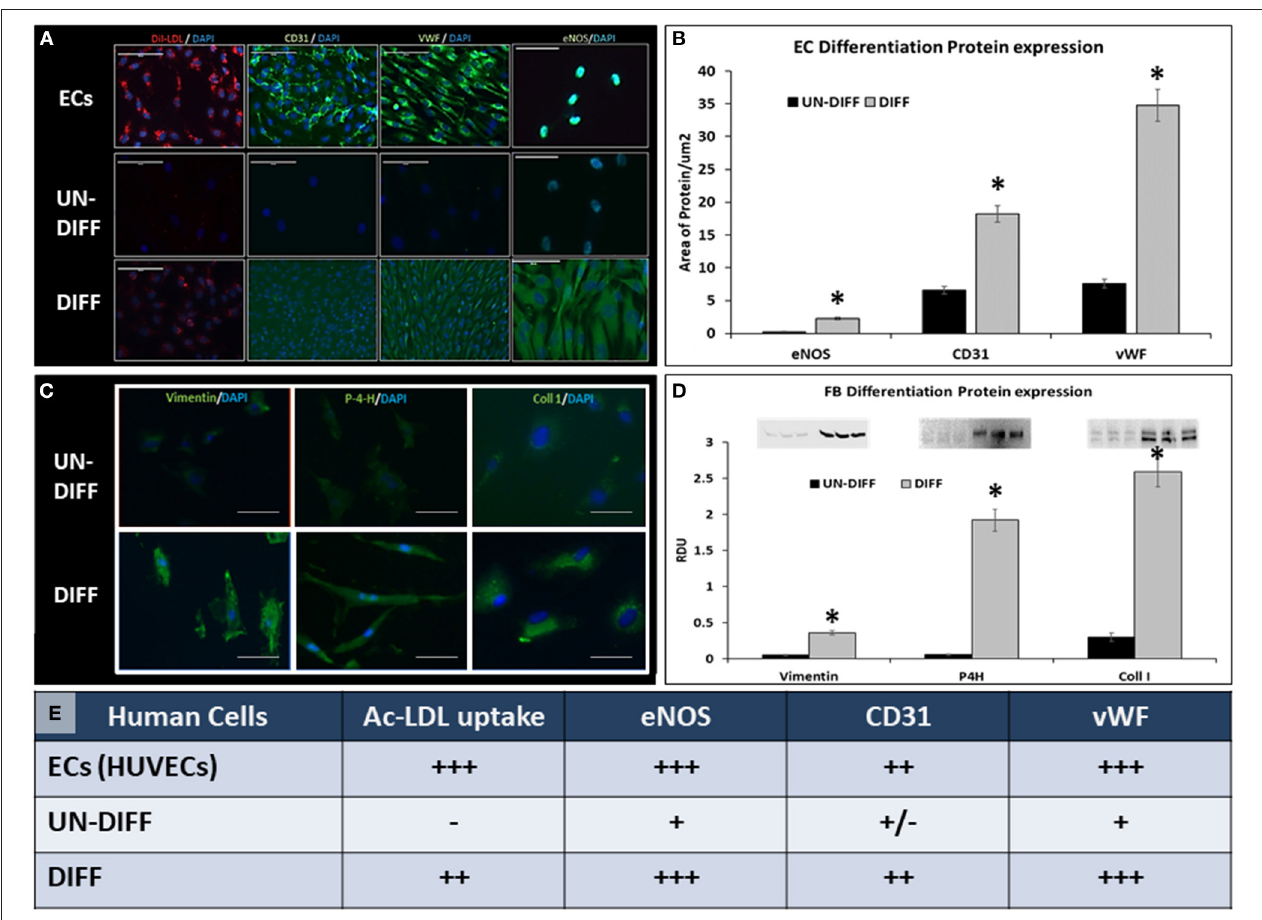
FIGURE 3 | Differentiation of adipose-derived stem cells. (A) For differentiation into ECs, ADSCs were subjected to ECGS media followed by dynamic shear. HUVECs (ECs) served as controls. For validation, cells were incubated with DiI-labeled LDL (DiI-LDL) and imaged by fluorescence microscopy (intracellular red particles). Cells were also immunostained for CD31, VWF, and eNOS (green, positive). Nuclei were stained with DAPI. Bars are 100 µ m. (B) amounts of positive eNOS, CD31, and VWF proteins in immunofluorescent images were assessed by semiquantitative image analysis normalized to area. For differentiation into FBs, ADSCs were exposed to low doses of TGF and stained for (C) vimentin, prolyl-4-hydroxylase (P-4-H), and collagen type I (Coll 1). Cells were also analyzed by Western blotting for same antigens and band intensity measured in the BioRad imager (D) . A semiquantitative analysis of cell differentiation is shown in (E) . Asterisk in Panels (B,D) designate statistically significant differences when compared to UN-DIFF. In all panels, UN-DIFF, undifferentiated stem cells; DIFF, stem cells that have been exposed to EC or FB differentiation